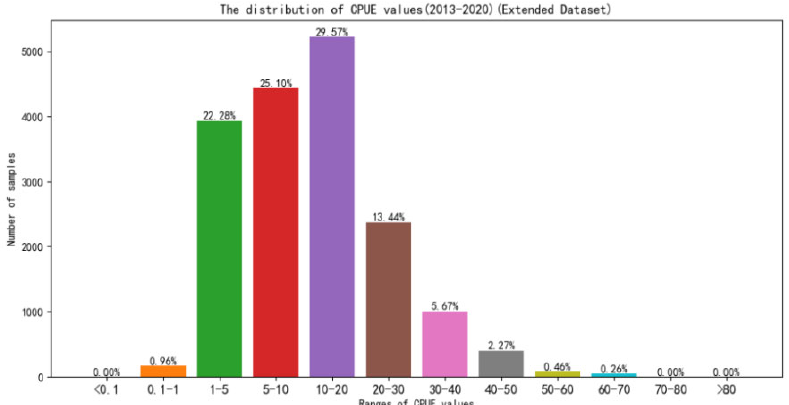
Figure 11. The distribution of samples of fisheries’ datasets in each month in 2013~2020.